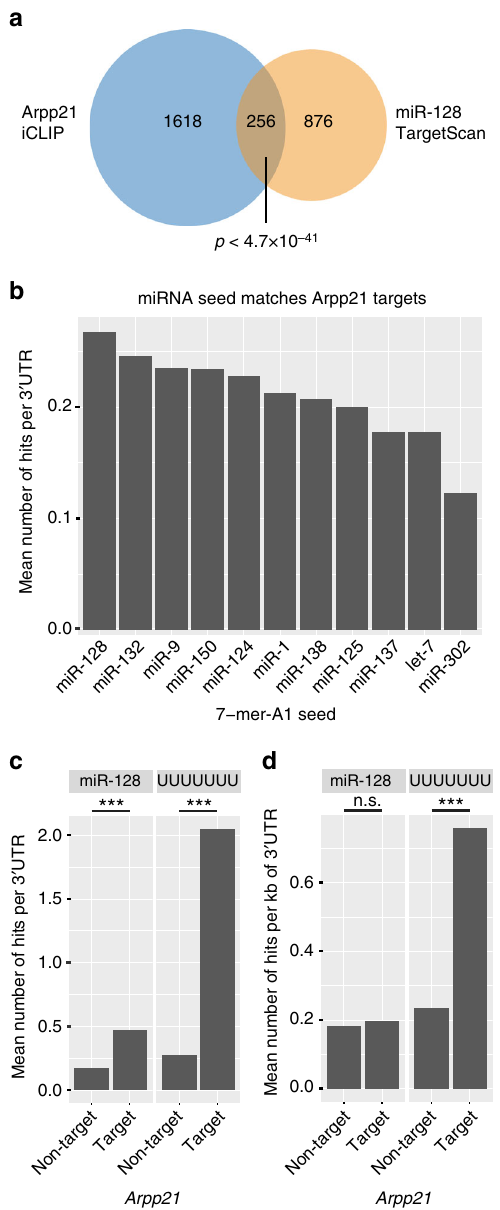
Fig. 5 ARPP21 and miR-128 bind an overlapping set of target mRNAs with related functions. a Venn diagram of conserved TargetScan 7.1 miR-128 target mRNAs, and ARPP21 iCLIP substrate mRNAs. b 7mer-A1 seed match occurrence per 3 ′ UTR of ARPP21 targets for several conserved miRNAs. c Number of occurrences of miR-128 seed matches and poly-uridine (poly-U) 7mers per 3 ′ UTR among ARPP21-bound and ARPP21-unbound transcripts. Both motifs are signi fi cantly enriched in 3 ′ UTRs of ARPP21 target mRNAs. Welch two-sample t -test, *** p < 2.2 × 10 − 16 . d miR-128 and poly-U 7mer occurrence normalized per kilobase of 3 ′ UTR